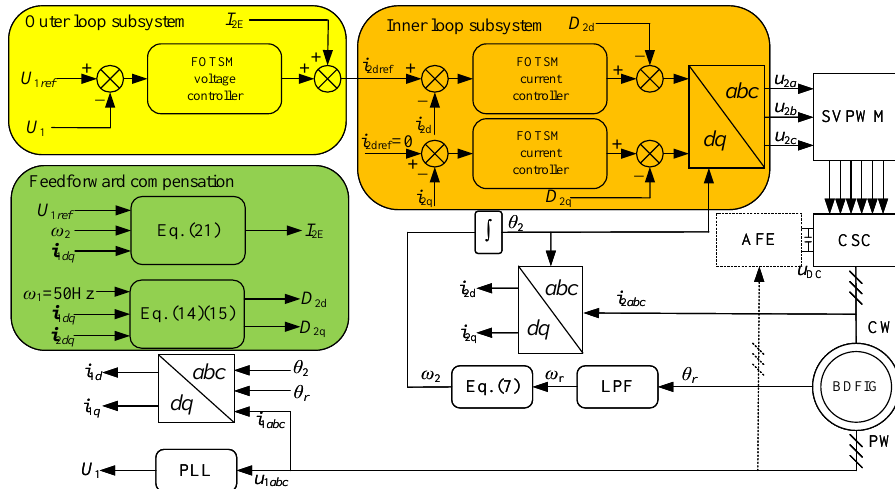
Figure 2. Block diagram of the control scheme of the standalone